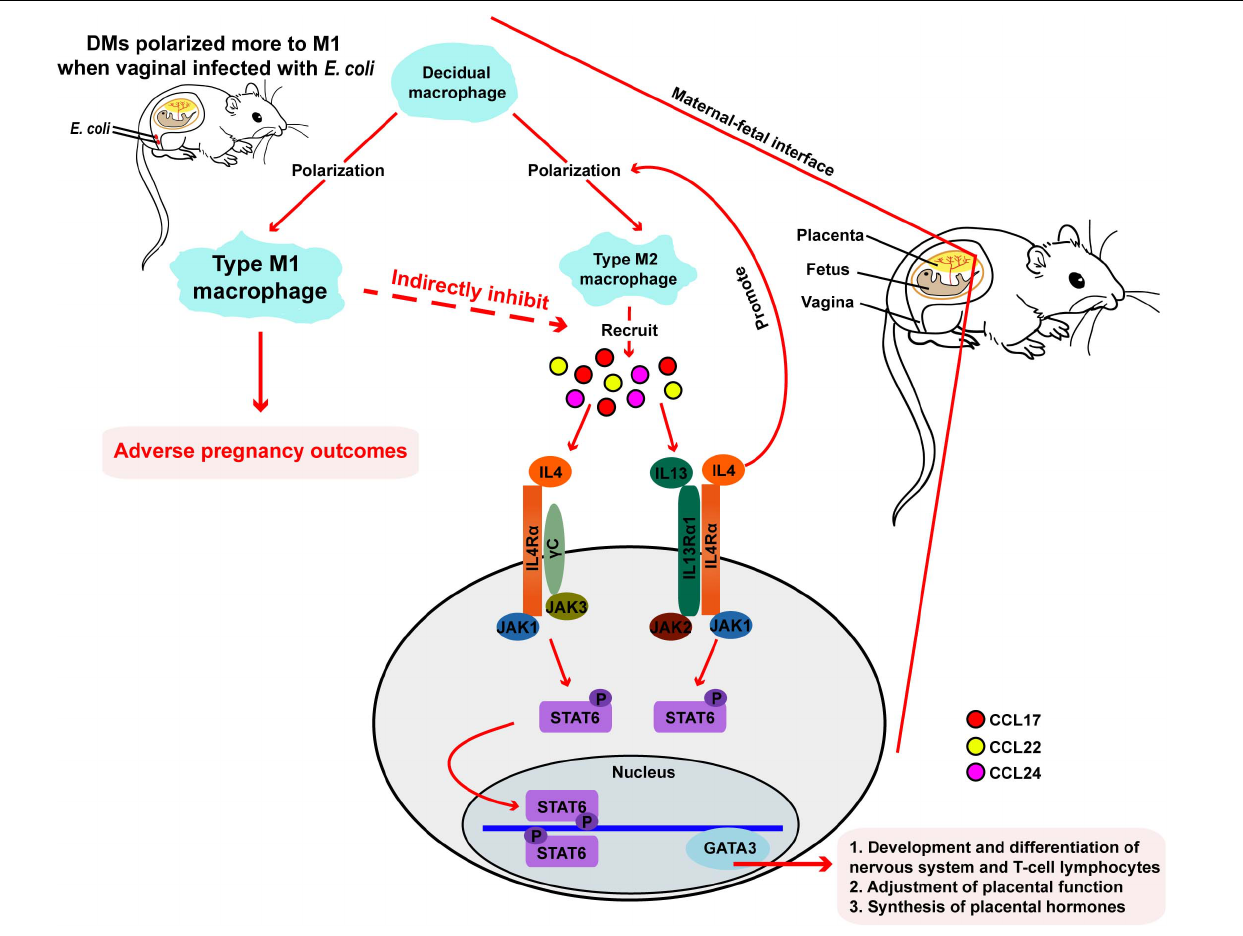
FIGURE 7 | Responses in the maternal-fetal interface during pregnancy in mice. During normal pregnancy, DMs polarized more to type M2 macrophages, following by recruiting some chemokines. Then, gene expression of downstream IL-4, JAK-1, STAT-6, and GATA-3 are upregulated, and pregnancy progresses toward normal. When mice are vaginally infected with E. coli , DMs transform more to M1 macrophages and adverse pregnancy outcomes